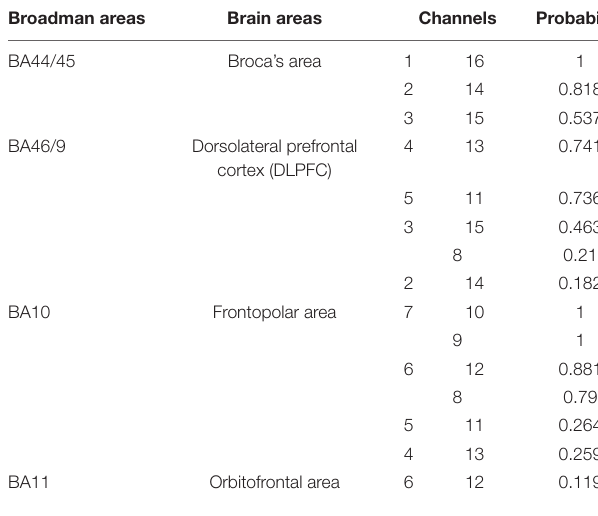
TABLE 2 | Broadman areas, brain regions, and the probability of corresponding fNIRS